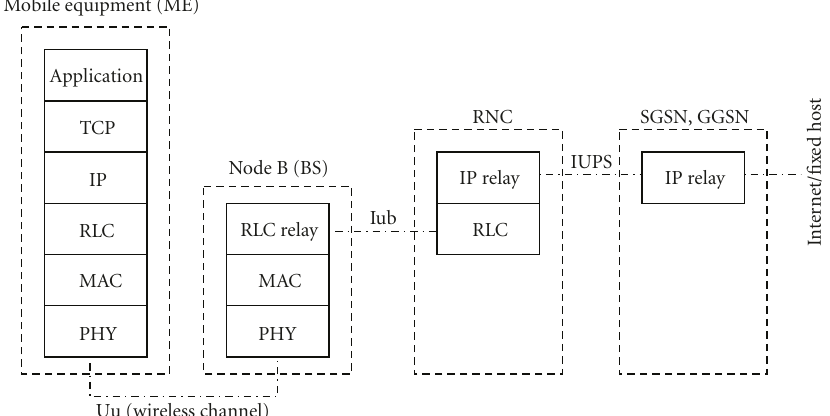
Figure 8: Example architecture which can be simulated with the Miracle UMTS module. ME is the mobile user, Node B is the UMTS base station (BS), RLC is the radio link control (hosting ARQ algorithms), RNC is the Radio Network Controller (in charge of connection handling, handovers, QoS control, call admission control, etc.), SGSN and GGSN are, respectively, the serving and gateway GPRS support